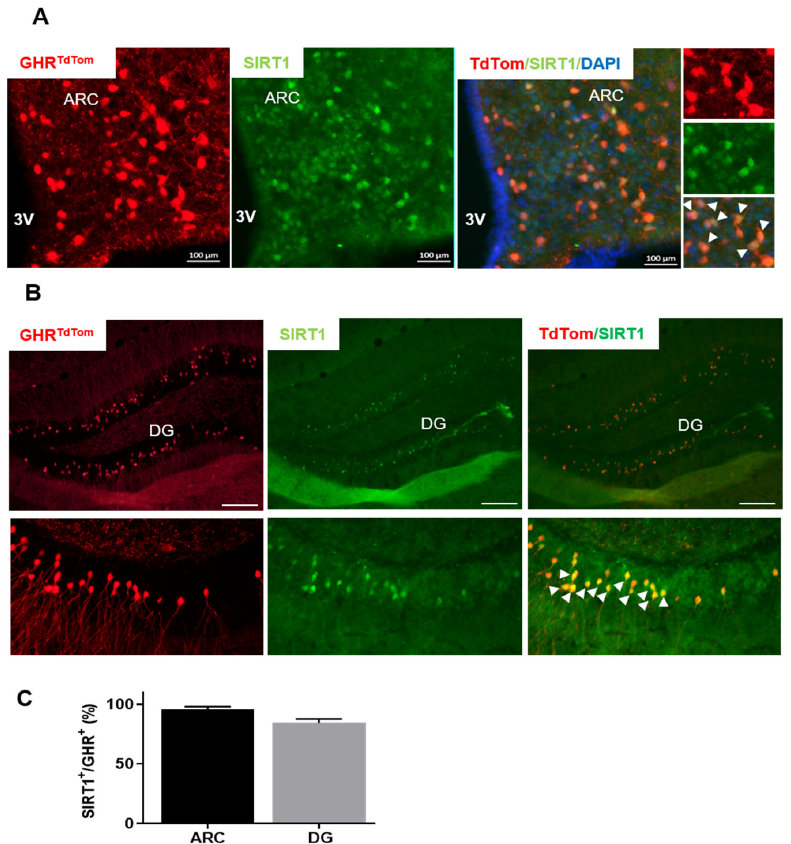
Figure 1. Sirtuin 1 (SIRT1) is co-localized with growth hormone receptor (GHR) + neurons. Representative fluorescence microscopy images of ( A ) the hypothalamus and ( B ) the hippocampus of fasted GHR tdTom mice. Red, tdTomato; green, SIRT1; the merged image shows co-localization between GHR and SIRT1 in the arcuate nucleus (ARC). The magnified images on the right side show the co-localization of tdTomato and SIRT1 fluorescence in the GHR + neurons (arrows). DG, dentate gyrus; ARH or ARC, arcuate nucleus of the hypothalamus. ( C ) The percentage of the GHR SIRT+ subpopulation from the total GHR + neurons in the ARC or DG. The data are shown as mean ± SEM. n = 4–5. The data were analyzed from both male and female mice. Scale bar: 100 µm. The 3V, third ventricle.